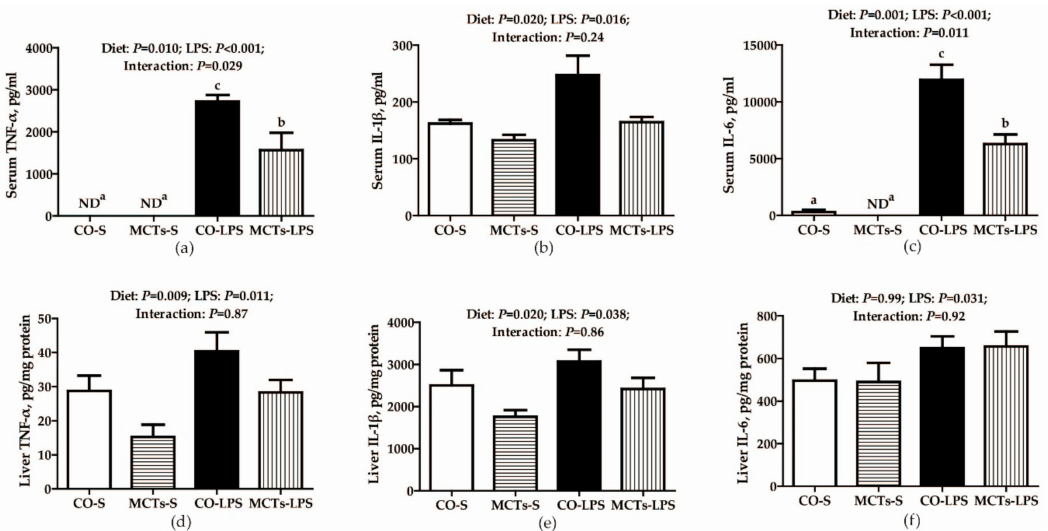
Figure 4. Effect of medium-chain triglyceride (MCT) supplementation on concentrations of serum ( a – c ) and liver ( d – f ) proinflammatory cytokines after 4-h LPS challenge in pigs. Values are mean and